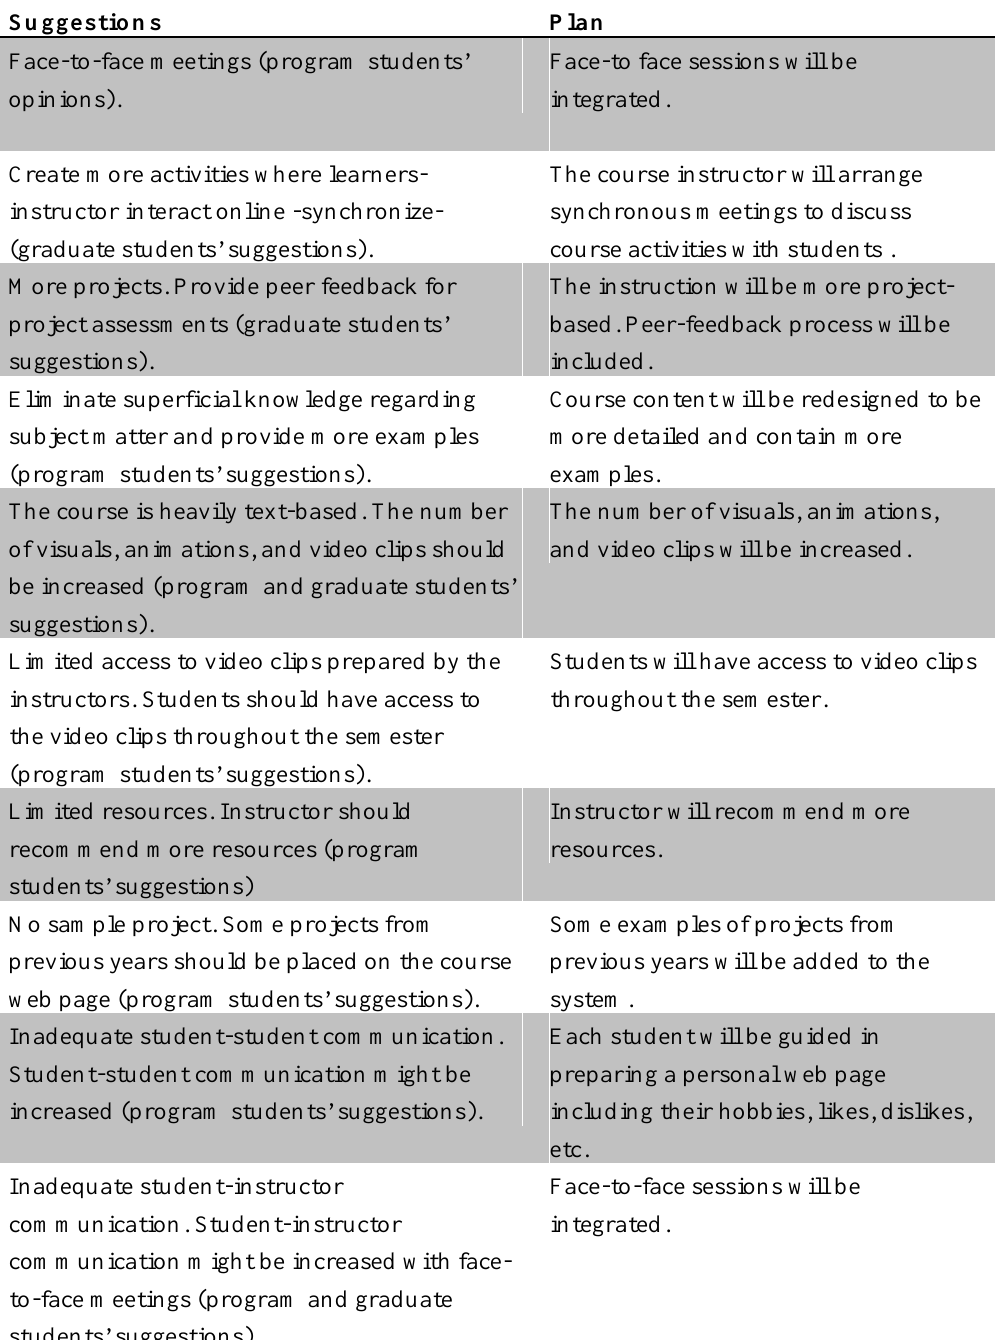
Tentative Course-Revision Plan Based on Views and